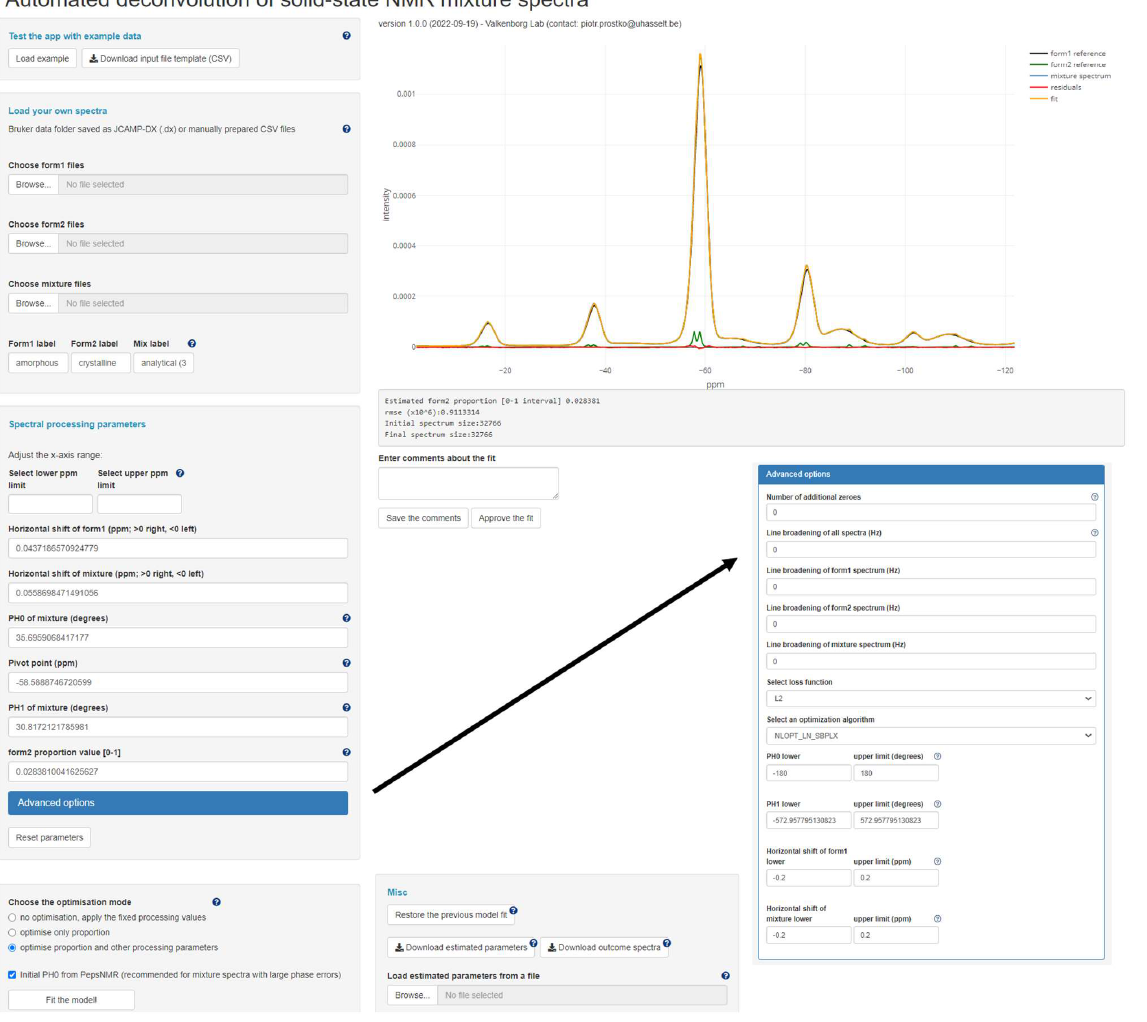
Figure 3. An expanded view of Graphical User Interface. A brief tutorial on how to use the app can be found in Supplementary